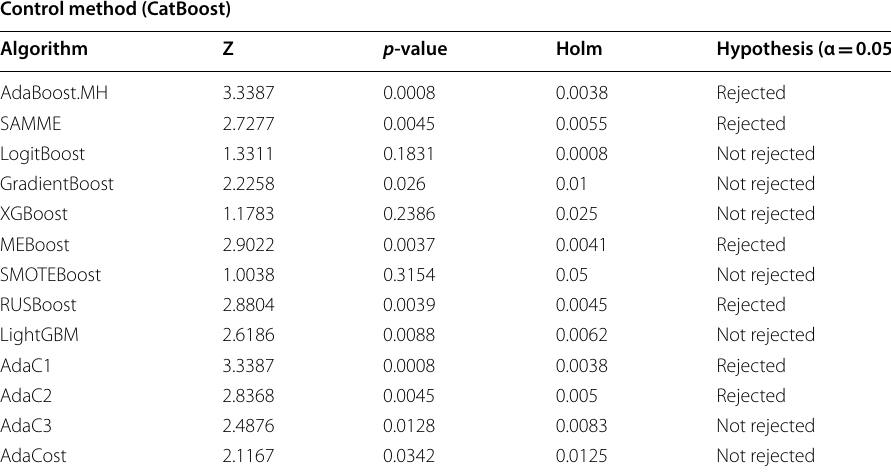
Table 4 Holm post-hoc test results based on the MAUCs Control method